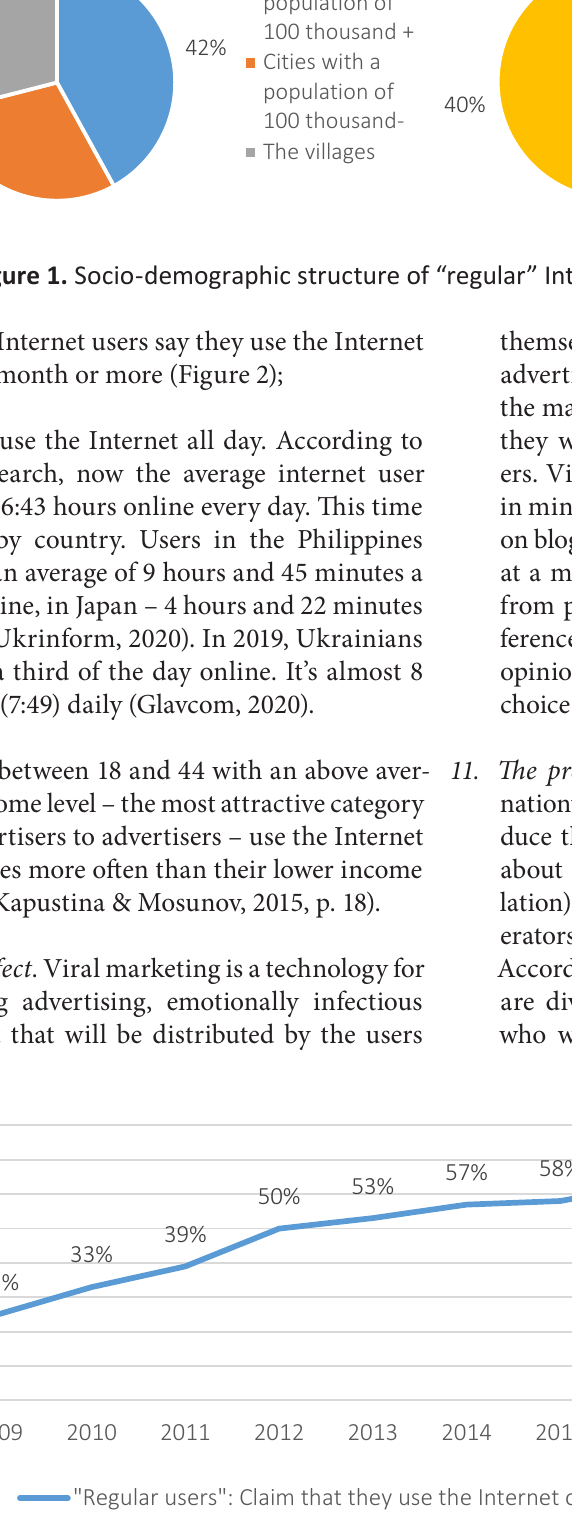
Figure 2. Dynamics of Internet penetration in Ukraine over the last 10